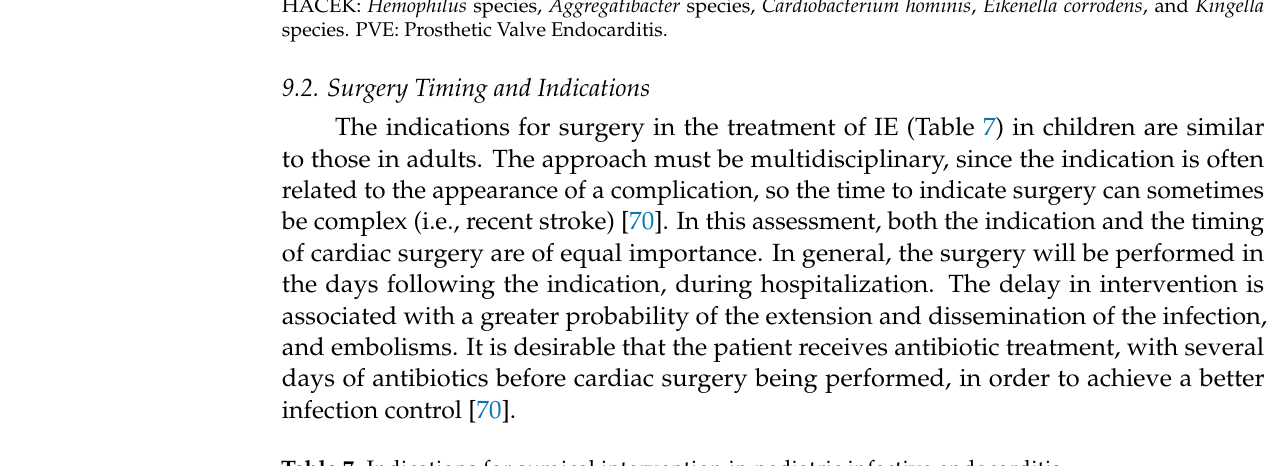
Table 7. Indications for surgical intervention in pediatric infective endocarditis. Indications for Surgery in Patients with Infective Endocarditis Valve dysfunction resulting in symptoms of heart failure Left-sided IE caused by S.